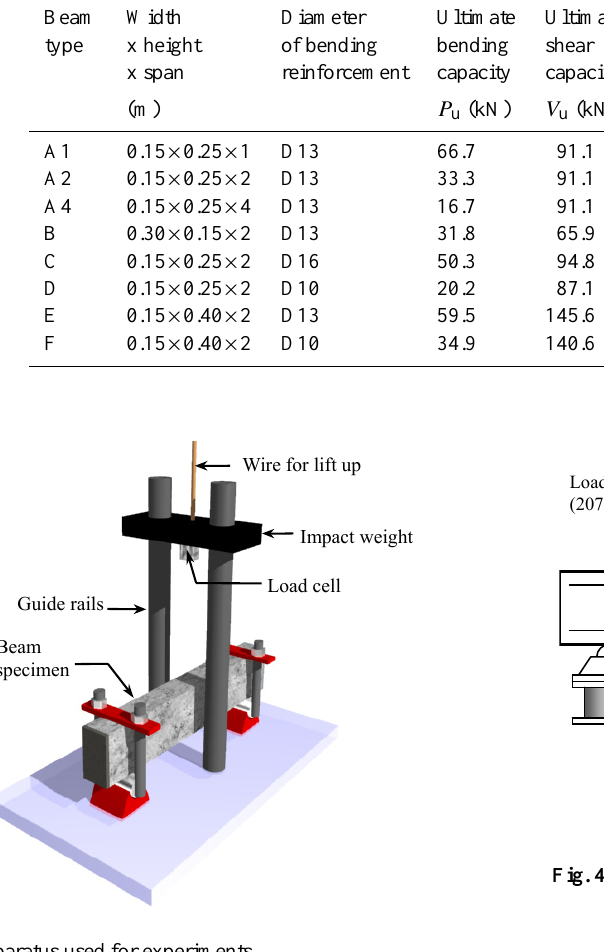
Fig. 3. Apparatus used for experiments.